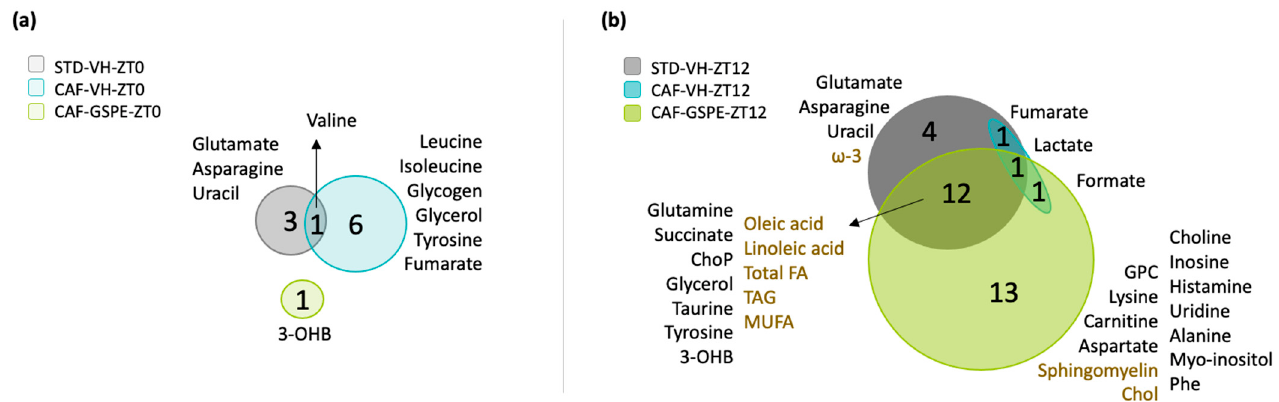
Figure 1. Overlap diagram of rhythmic metabolite concentrations presented in ZT0 ( a ) and ZT12 groups ( b ). Rats were fed standard or cafeteria diet for 9 weeks. At week 6, rats received a daily oral dose of GSPE or vehicle for 4 weeks at ZT0 or ZT12. Rats from each group were sacrificed at four different time points: ZT1, ZT7, ZT13, and ZT19 in order to analyze the diurnal rhythm of these metabolites. Forty-five metabolites detected by NMR were analyzed using CircaCompare algorithm based on Cosinor ( p < 0.05). Metabolites from aqueous phase are shown in black color and metabolites from lipidic phase in brown color. Abbreviations: iWAT, inguinal adipose tissue; ZT0, beginning of the light phase; ZT12, beginning of the dark phase; STD-VH-ZT0; standard diet vehicle group treated at ZT0; CAF-VH-ZT0, cafeteria diet vehicle group treated at ZT0; CAF-GSPE-ZT0, cafeteria diet treated with grape-seed procyanidin extract at ZT0; STD-VH-ZT12; standard diet vehicle group treated at ZT12; CAF-VH-ZT12, cafeteria diet vehicle group treated at ZT12; CAF-GSPE-ZT12, cafeteria diet treated with grape seed procyanidin extract at ZT12; 3-OHB, 3-Hydroxybutyr- ate; Chol, cholesterol; Total FA, total fatty acids; TAG, triacylglyceride; MUFA, monounsaturated fatty acids; ω -3, omega-3; GPC, glycerophosphocholine; Phe, phenylalanine; ChoP, phosphorylcho- line.